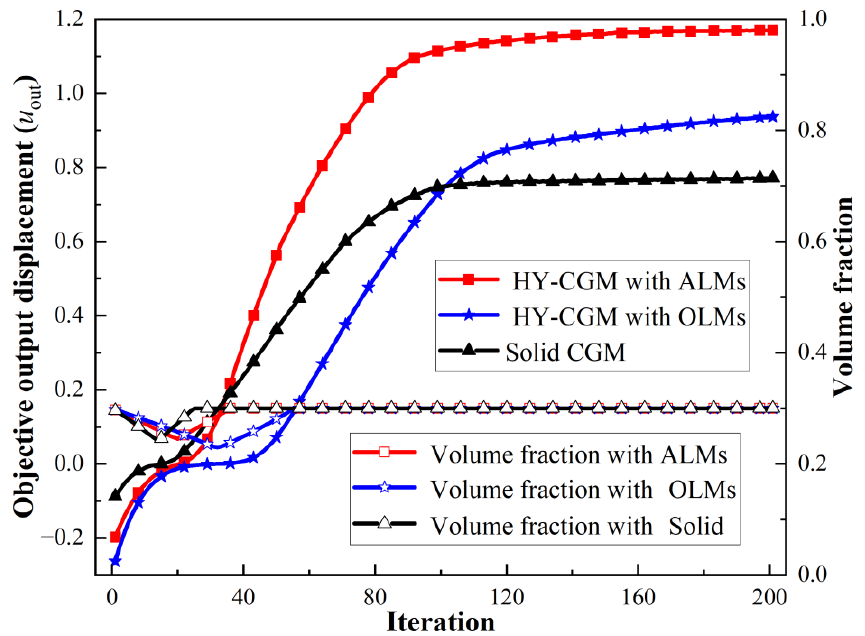
Figure 10. Iteration histories of objective output displacement and volume faction of the CGMs.